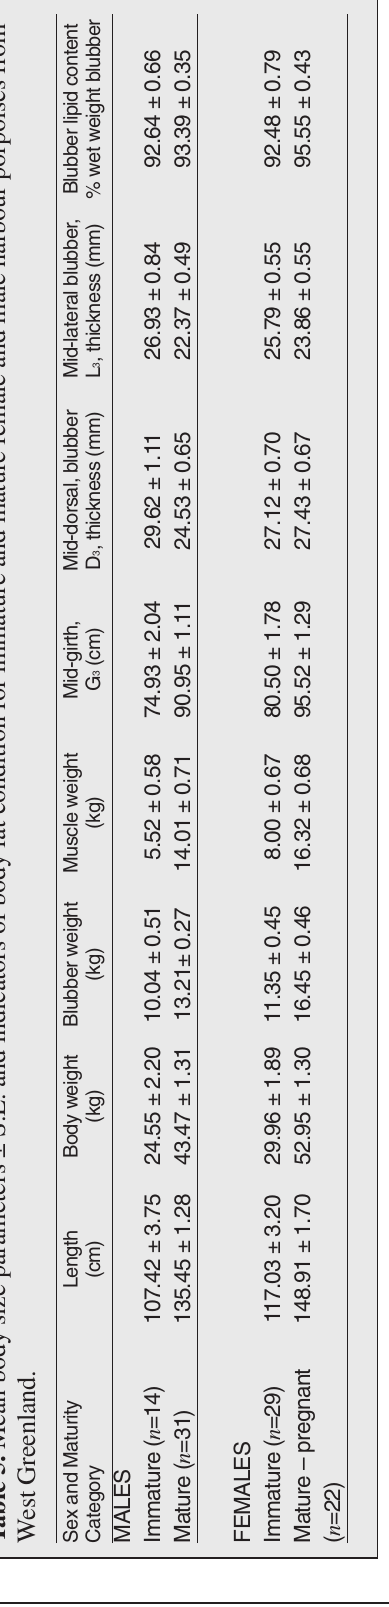
Fig. 9 shows weight at length relationships for males and females. Comparison with similar weight at length relationships for other areas (Lockyer 1995c, d, Lockyer and Kinze 2003) indicates that while the British and Danish por- poises are similar, the West Greenlandic por- poises are consistently heavier for their length. 150 cm weighing 53.1 kg off Denmark and 53.3 the British Isles.